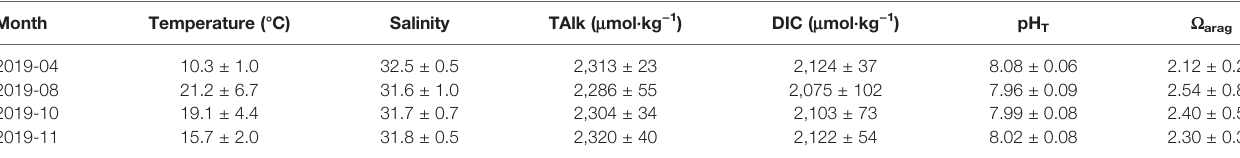
TABLE 1 | Cruise information including water temperature, salinity, and carbonate system parameters (mean ± standard deviation) from seasonal mapping cruises carried out in